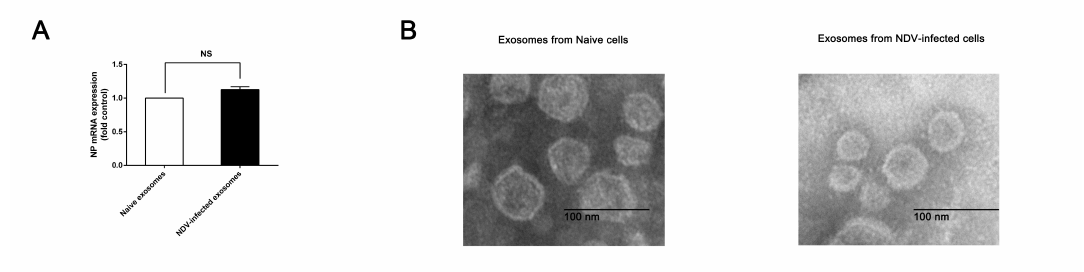
Figure 1. ( A ) Exosomes were extracted from naive and Newcastle disease virus (NDV)-infected HeLa cells. ( B ) The images of exosomes secreted by NDV-infected and naive HeLa cells were obtained using TEM. The size bar is 100